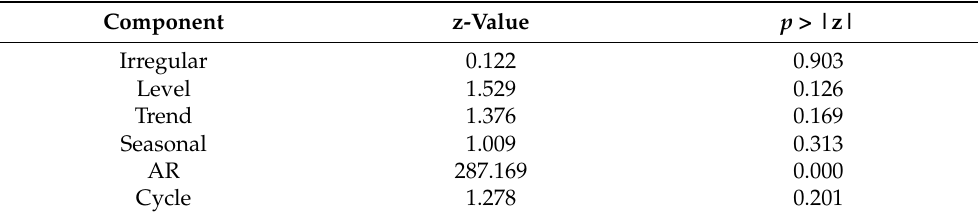
Table A1. Statistical test of UCM-components (univariate baseline model as described in Section 5).